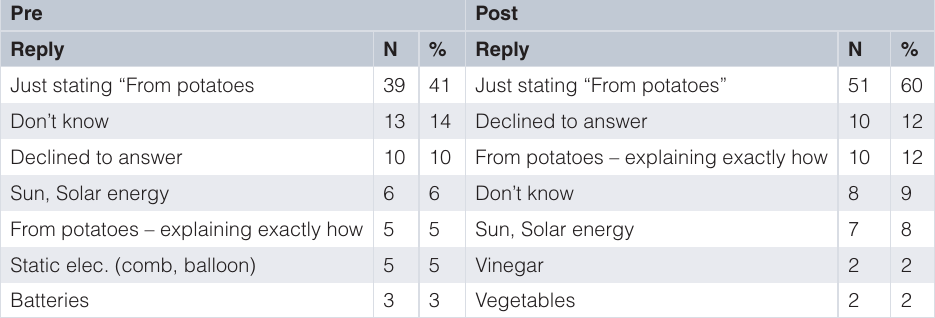
Table 3. Comparison of knowledge before and after the learning session. “How can we create electricity on our own”. Pre